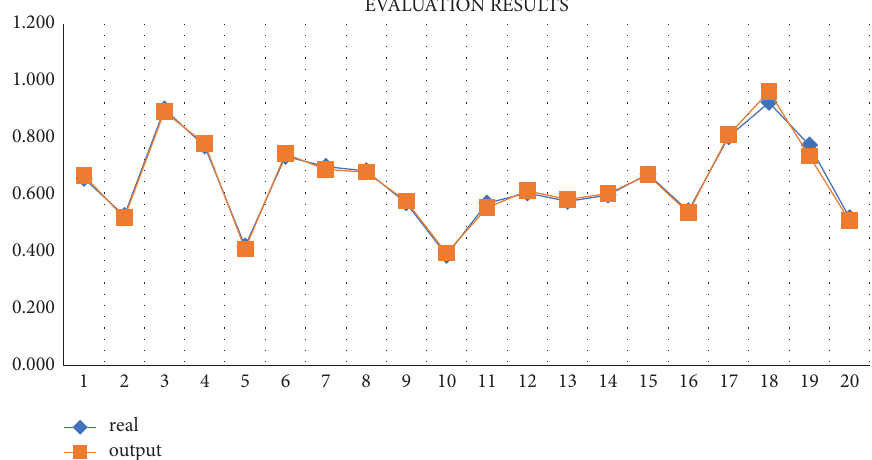
Figure 4: Evaluation